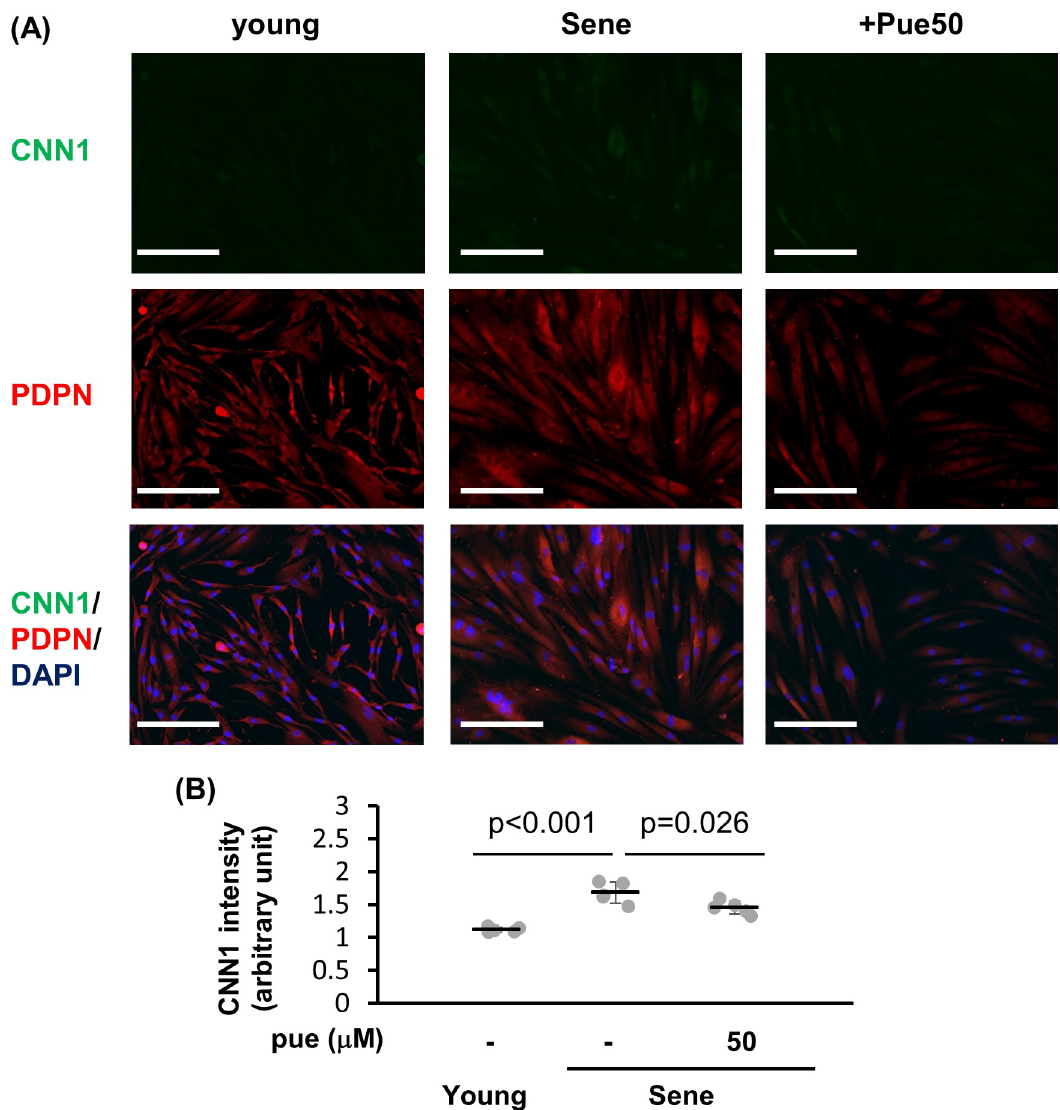
Fig 6. The effect of puerarin on CNN1 and PDPN expressions in senescent NHDFs. (A) Young or senescent (sene) NHDFs with or without 50 μ M puerarin (+pue 50) were stained for CNN1 (green) and PDPN (red) by the immunocytochemical method. (B) Fluorescent intensities of CNN1 positive area were calculated from 5 microscpic fields for each group. Scale bars = 100 μ m.